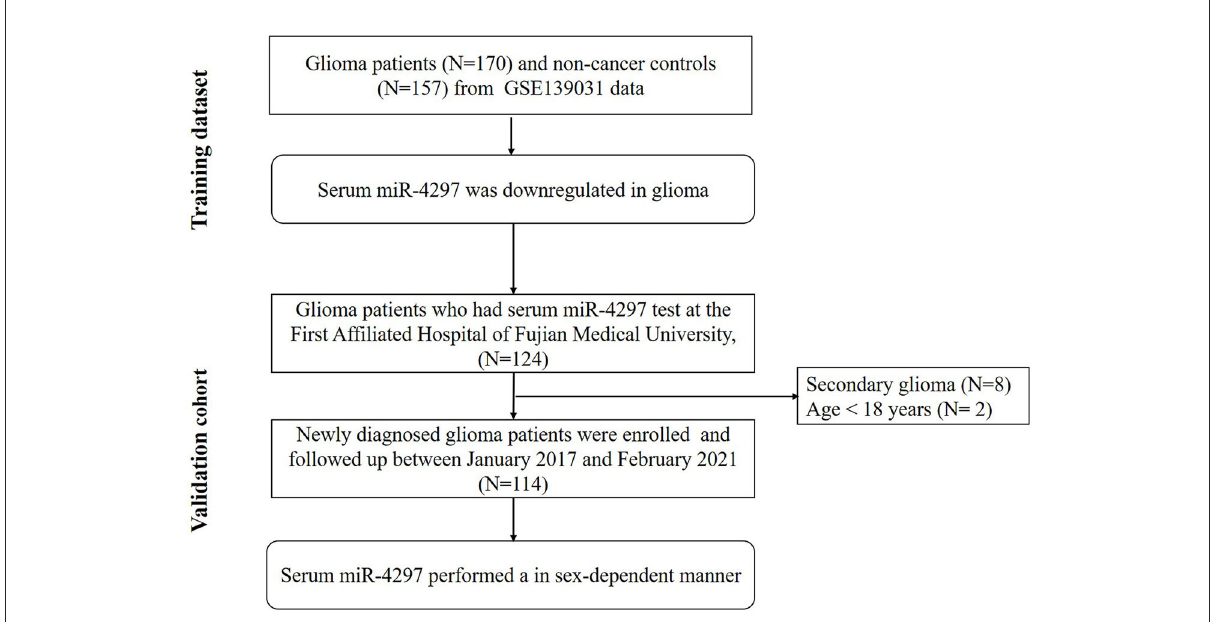
FIGURE1 Flow chart describing the process for exploring the sex-specific role of